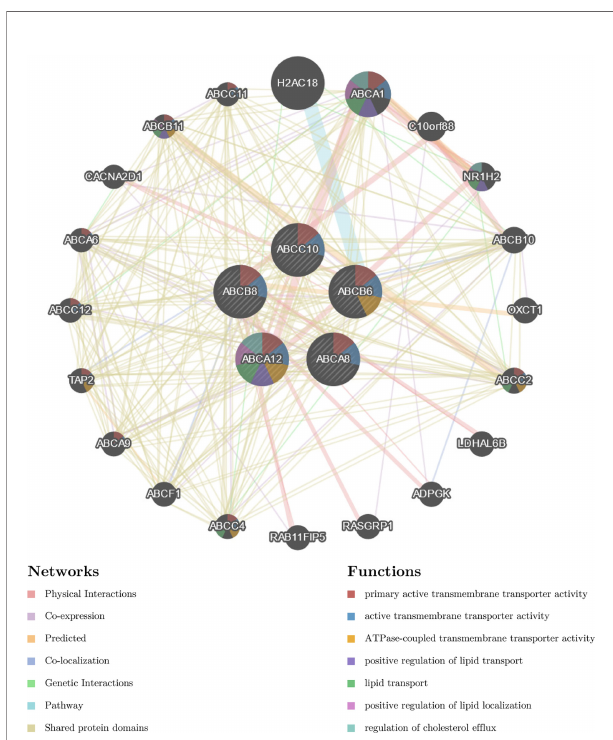
FIGURE 6 | The constructed gene regulation network of fi ve hallmark ABC transporters and 100 genes, which were most highly correlated with fi ve hallmark ABC